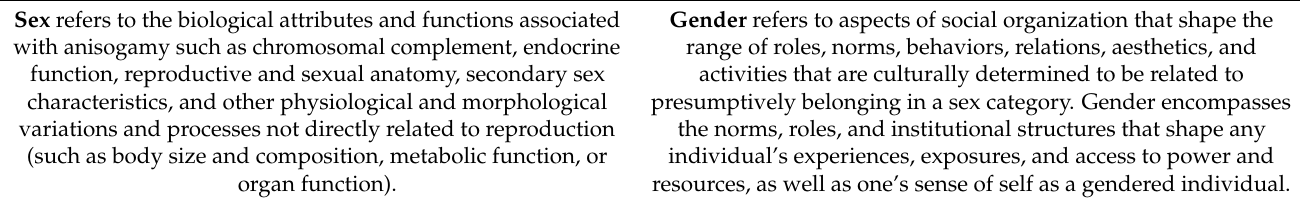
Table 1. Provisional definitions of sex and